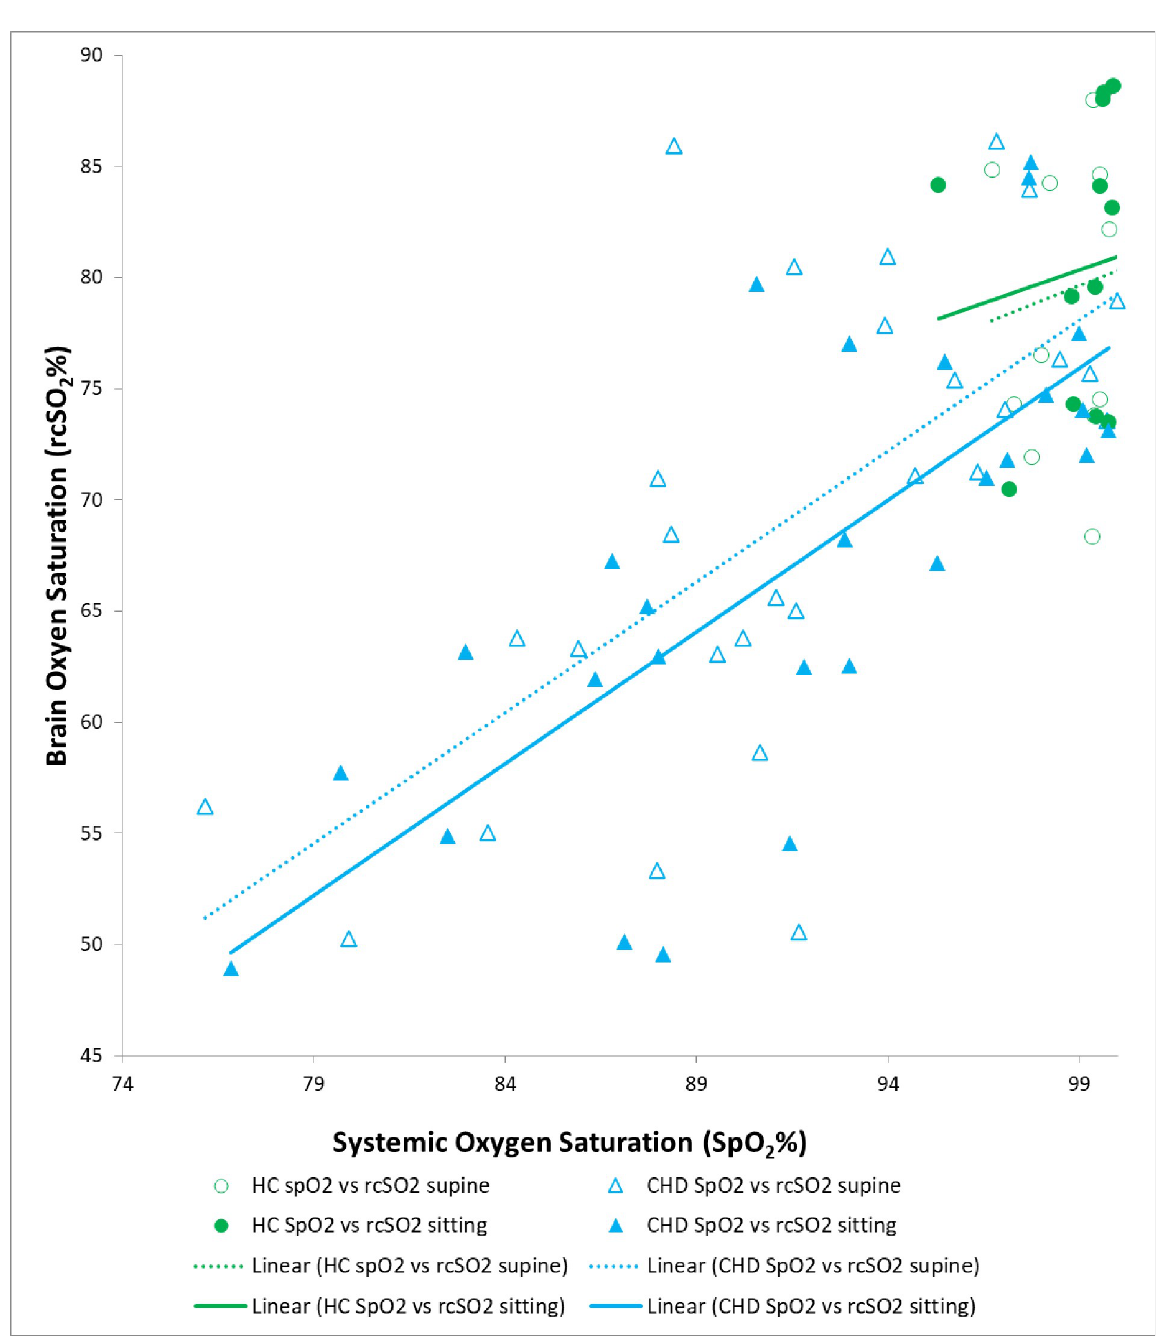
Fig 3. Association of brain oxygen saturation (rcSO 2 ) with systemic oxygen saturation for CHD and healthy infants in supine and sitting postures. The significant correlation of rcSO 2 with SpO 2 is apparent in each posture within each group. In addition, a difference in mean rcSO 2 values between the HC and CHD groups is apparent after accounting for the correlation of rcSO 2 with SpO 2 , in that the regression lines are nearly parallel, though the CHD regression lines extend nearly 10 rcSO 2 units below the HC regression lines. CHD = congenital heart disease; HC = healthy control; rcSO 2 = regional cerebral oxygen saturation; SpO 2 = peripheral oxygen saturation. posture interaction were similar when excluding preductal peripheral arterial oxygen satura- tion as a covariate ( β = -2.4; 95% CI = -4.11, -0.68; p = 0.006). Including fractional tissue oxy- gen extraction as an additional covariate did not appreciably alter these findings.